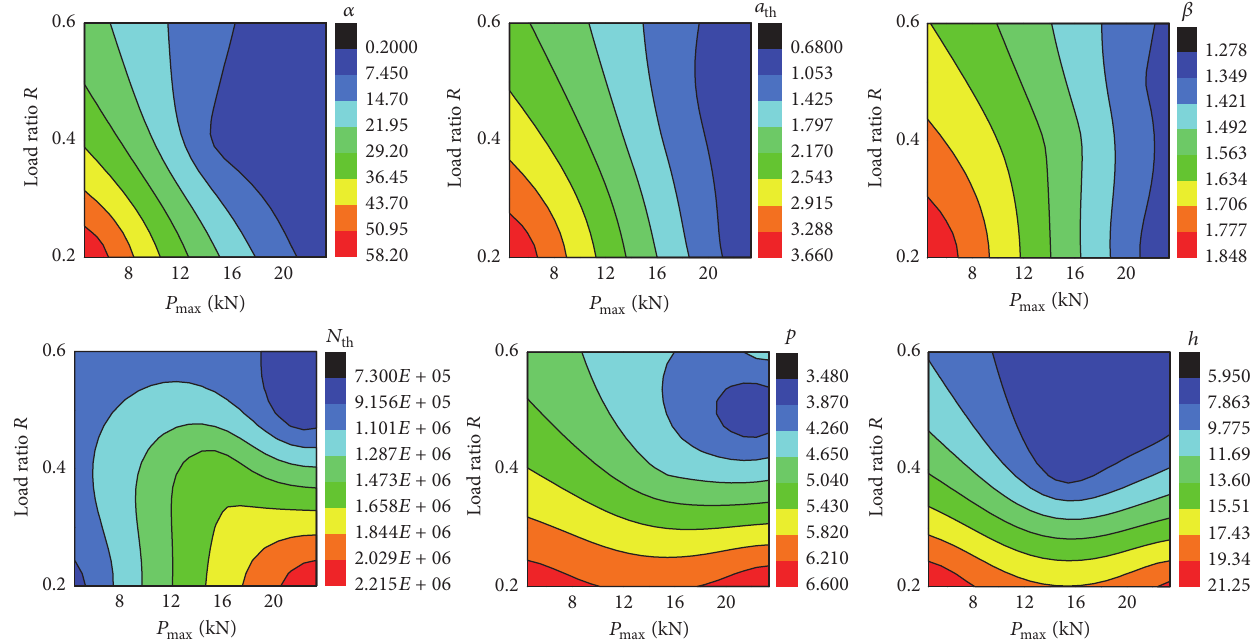
Figure 7: Contour plot of the model parameter average values in function of the loading conditions.